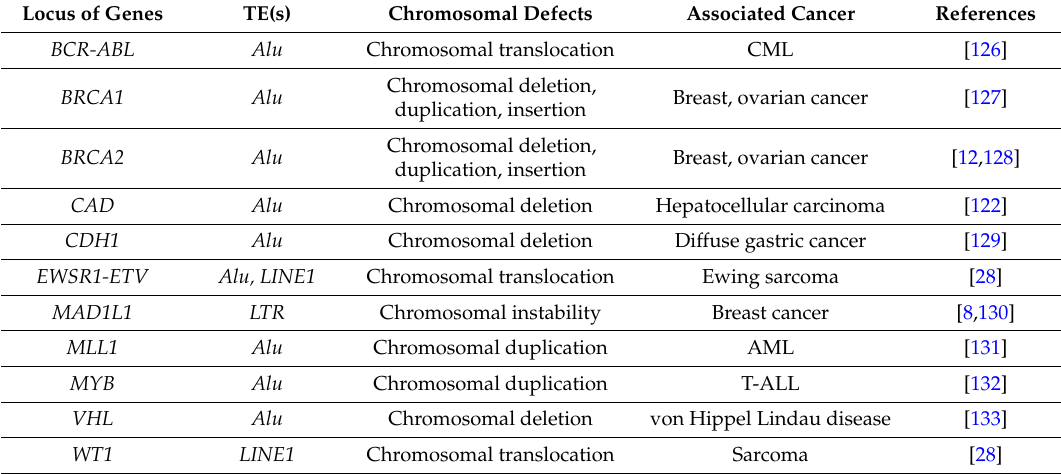
Table 3. TE-mediated chromosomal structure defects in human